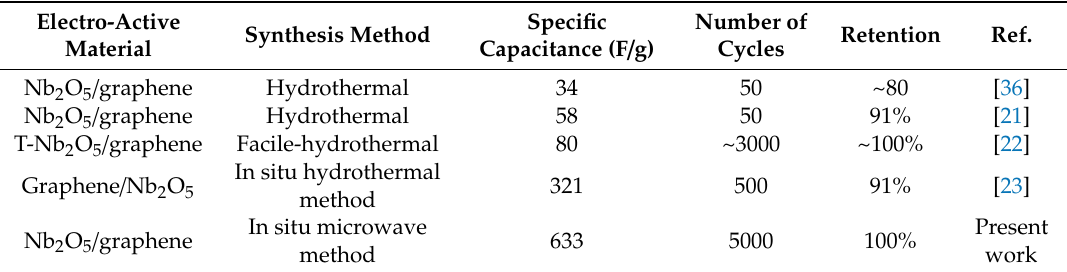
Table 1. The specific capacitance and retention of Nb 2 O 5 / G nanocomposite electrodes synthesized by di ff erent methods.